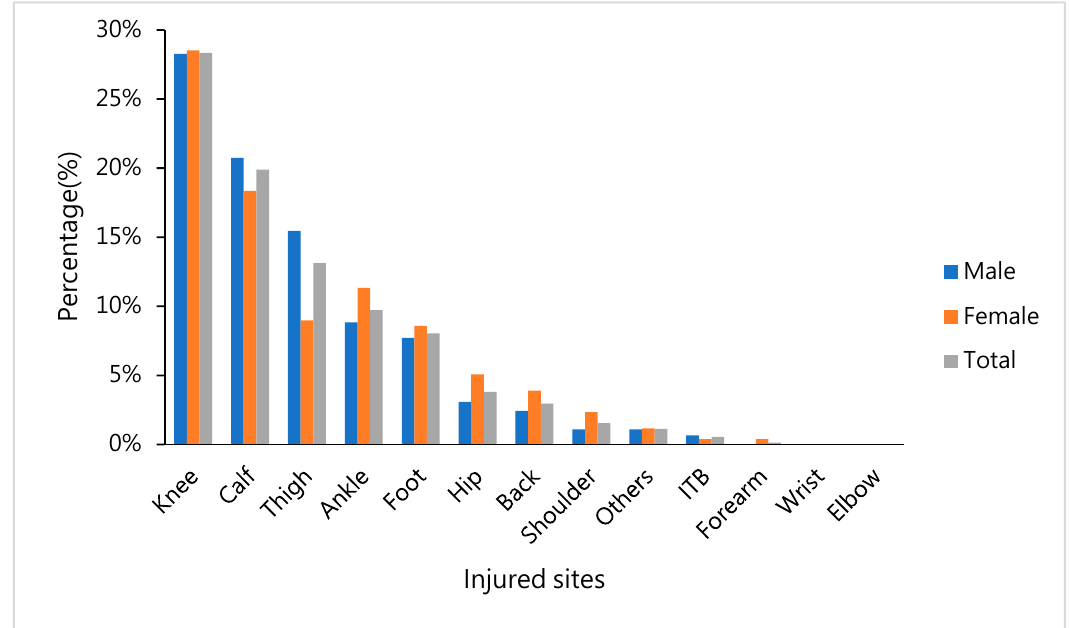
Figure 3. Percentage of self-reported influence on the injury sites in the body after the gorge marathon, shown for men, women, and total percentage.